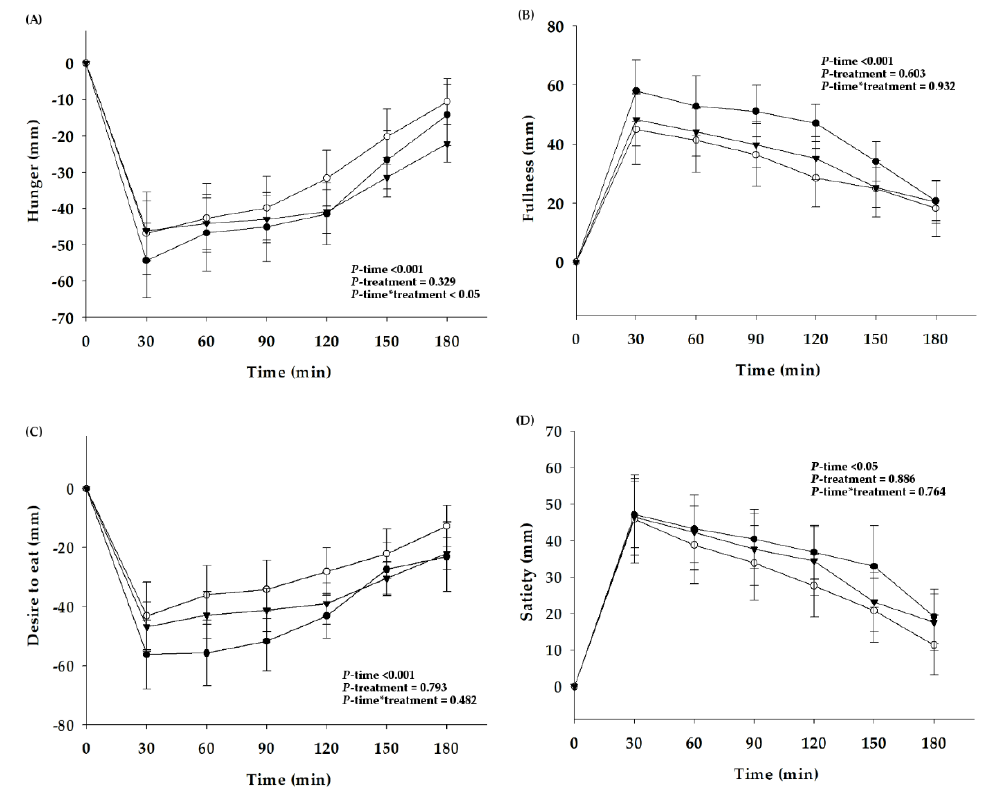
Figure 10. ( A ) Changes in hunger, ( B ) fullness, ( C ) desire to eat, and ( D ) satiety of healthy participants after the consumption of wheat bread (WB), Riceberry rice bread (RRB), and Hom Mali bread (HMB). All values are means ± SEM, n = 16. WB (●), RRB, ( ○ ), and HMB ( ▼ ). For each time point, means with a different letter are significantly different, p < 0.05.